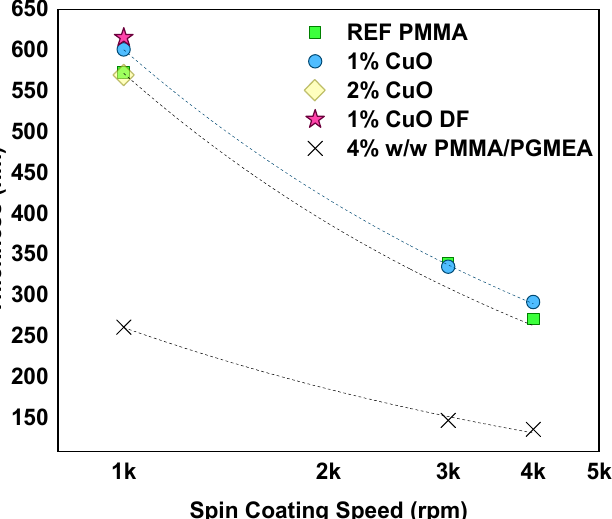
Figure 4. Spin curves for the “bare” PMMA reference samples (green squares), the nanocomposites containing 1% w / v CuO (blue circles), sample 2%CuO-1k (yellow diamond) and 1%CuO-1k-DF (magenta star). Crosses correspond to the 4% w / w PMMA/PGMEA.